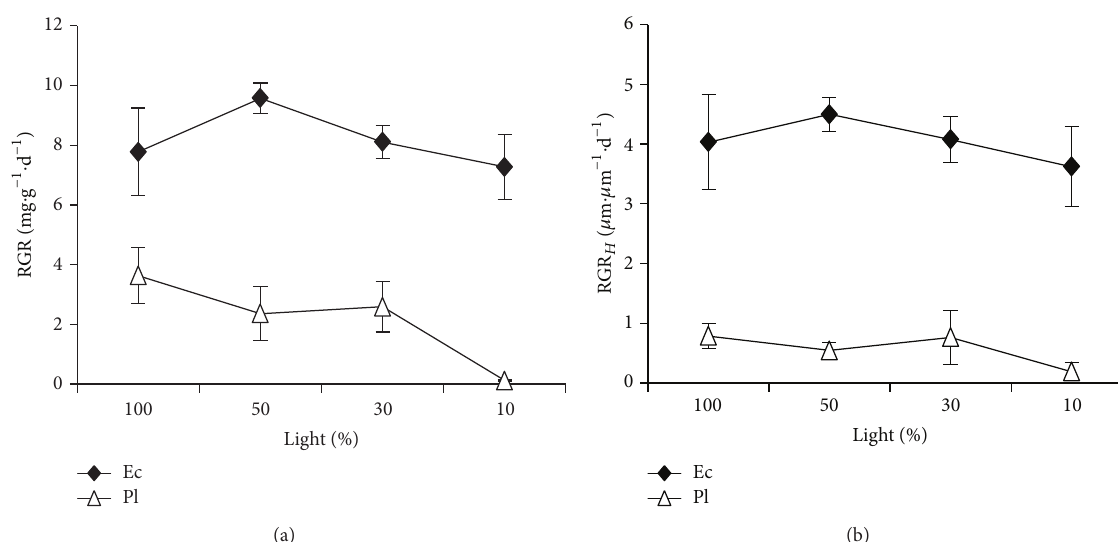
Figure 1: Growth rate responses to light for two rain forest tree species. Figures refer to (a) relative growth rate and (b) relative height growth